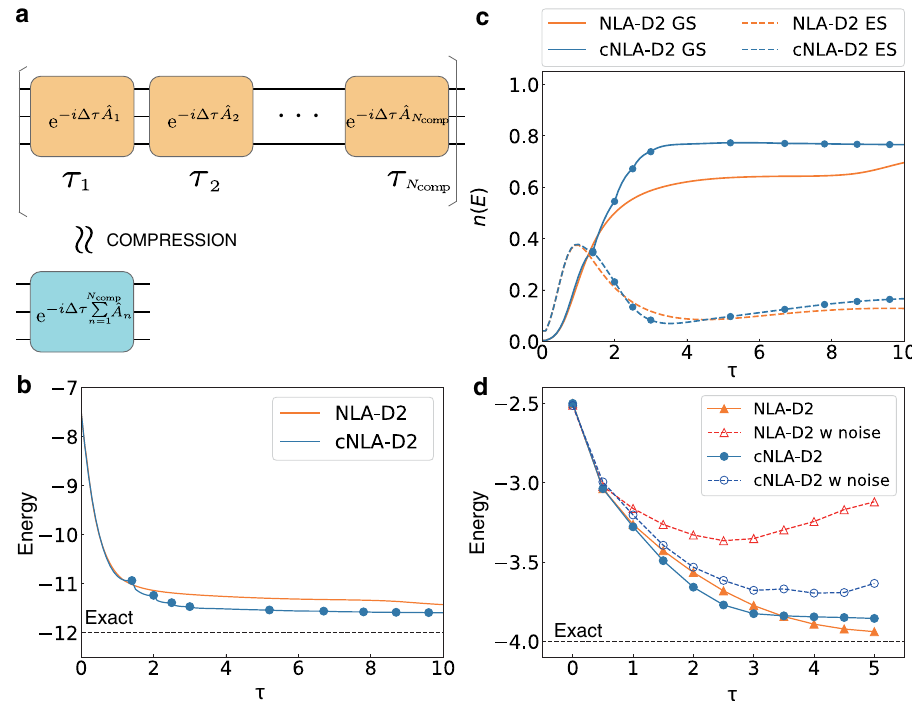
Fig. 3 Numerical simulation of compression of imaginary-time steps. a Schematic of the compression of the imaginary-time step. N comp steps are compressed into one step by 1st-order Suzuki – Trotter decomposition. Energy E ( b ) and component of the eigenstate n ( E ) ( c ) in the imaginary-time evolution with and without compression of the imaginary-time step in the max-cut problem of an unweighted 3-regular graph with ten vertices. The compressed point N comp is plotted with circles. d Results of the simulation with noise for the max-cut problem in an unweighted graph with four